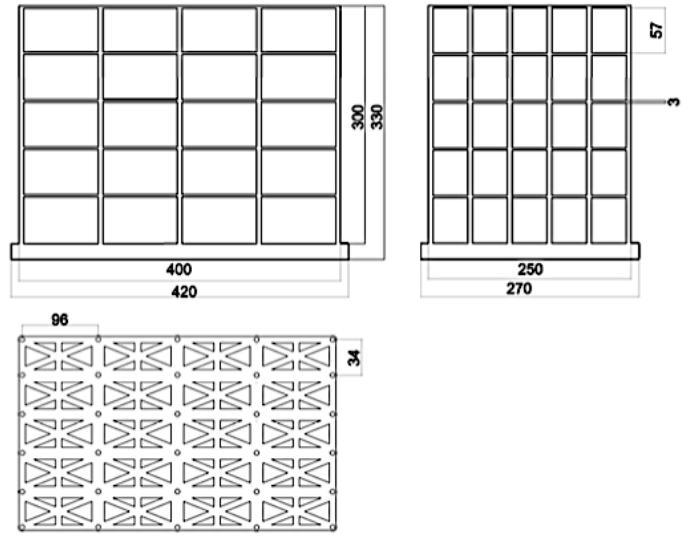
Figure 2. Canceled structure.